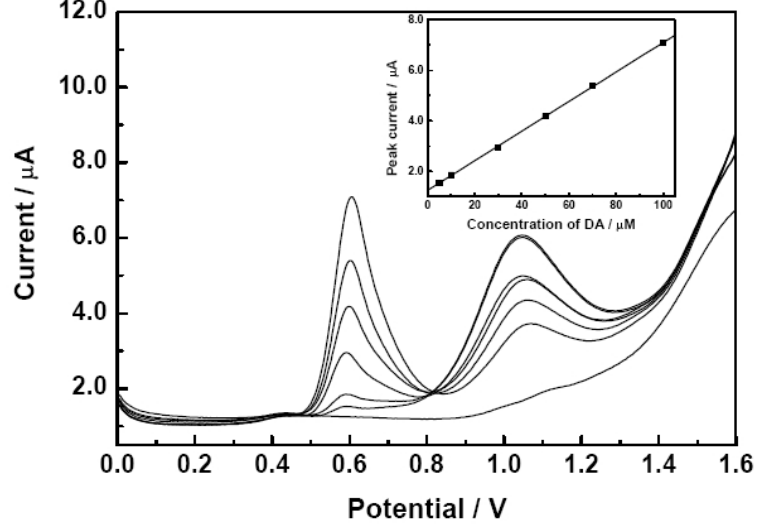
Fig. 6 DPVs of the DA in the presence of 1 × 10 − 3 M AA on BDD electrode; analytical concentration of DA , from bottom to top: 0 . 5 × 10 − 6 , 1 × 10 − 5 , 3 × 10 − 5 , 5 × 10 − 5 , 7 × 10 − 5 , 1 × 10 − 4 M. Inset figure is linear correlation between peak current and concentration of DA. (The increment E: 0.004 V; Amplitude: 0.05 V; Pulse width: 0.05 s; Pulse period: 0.2